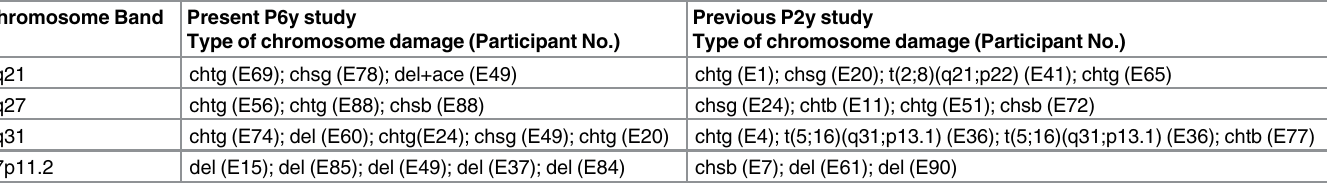
Table 3. Type of spontaneous chromosome damage on the most affected bands in exposed individuals two and six years after oil spill exposure. Chromosome Band Present P6y study Previous P2y study Type of chromosome damage (Participant No.) Type of chromosome damage (Participant